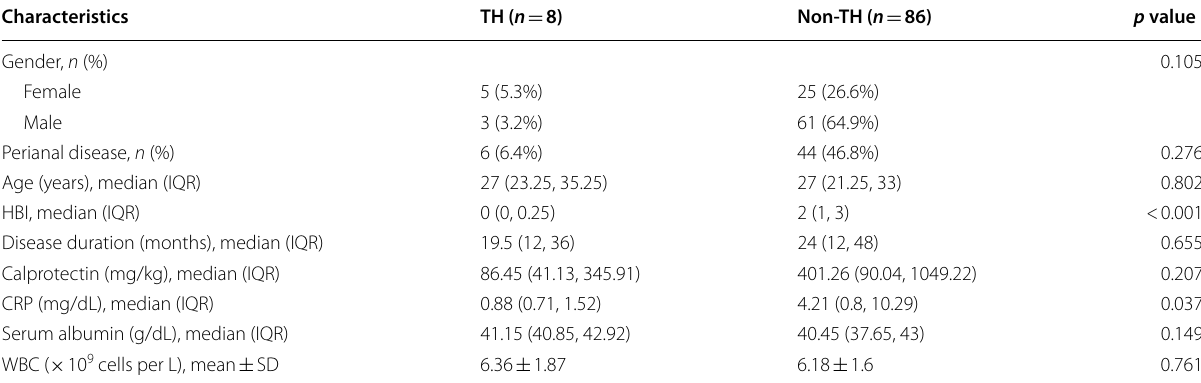
TH Transmural healing, CRP C-reactive protein, HBI Harvey–Bradshaw index, WBC White blood cell, IQR Interquartile range, SD Standard deviation